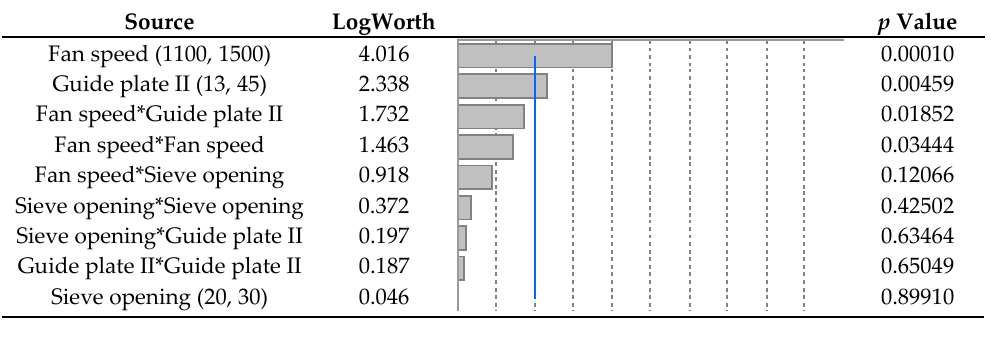
Table 4. Surface response experimental results for grain sieve loss.